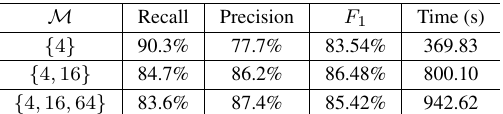
Table 2. Information on the evaluation